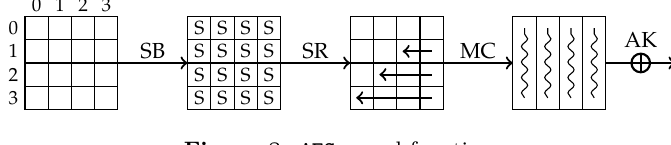
Figure 8: AES round